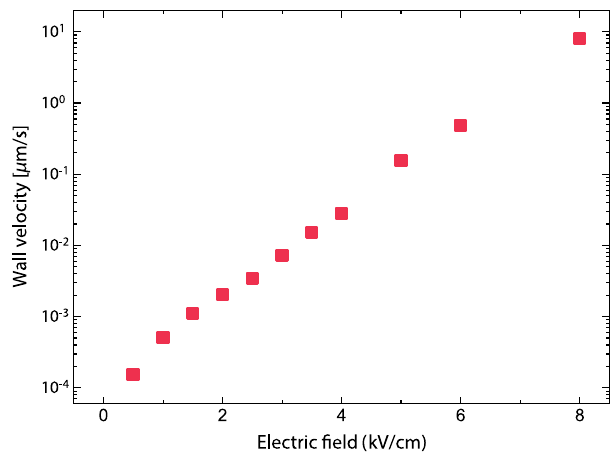
FIG. 5. Magnetic domain-wall velocity as a function of applied electric